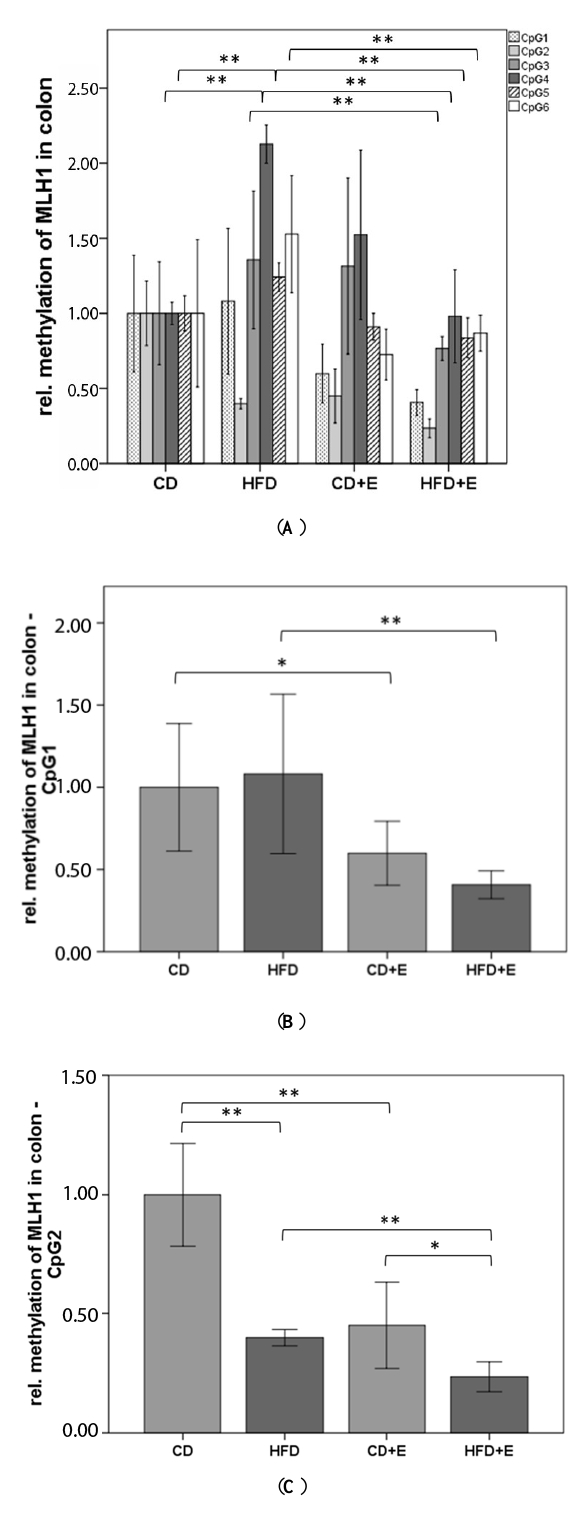
Figure 6. Relative CpG methylation status in promoter region of MLH1 in colon of C57BL/6J male mice ( n = 5): ( A ) mean methylation status for MLH1 in colon is shown as an overview; ( B ) the methylation status of CpG 1; and ( C ) the methylation status of CpG 3 is specified. All methylation data are shown relative to CD. The error bar represents a 95% confidence interval. (CD = control diet; HFD = high fat diet; CD + E = control diet plus vitamin E; HFD + E = high fat diet plus vitamin E; * p -value ≤ 0.05; ** p -value ≤